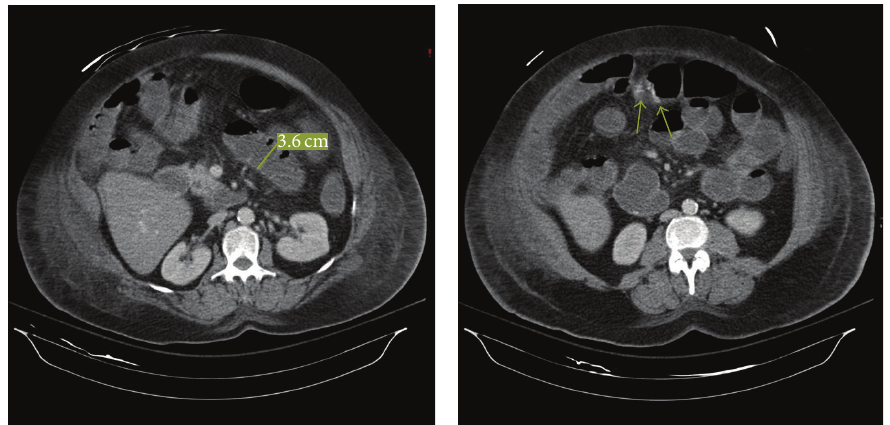
Figure 1: Computed tomography of the abdomen and pelvis with IV and PO contrast demonstrated diffuse dilation and fluid filling in the small bowel to the level of the ileocolic anastomosis out of proportion to the large bowel gas concerning for low-grade small bowel obstruction versus postoperative